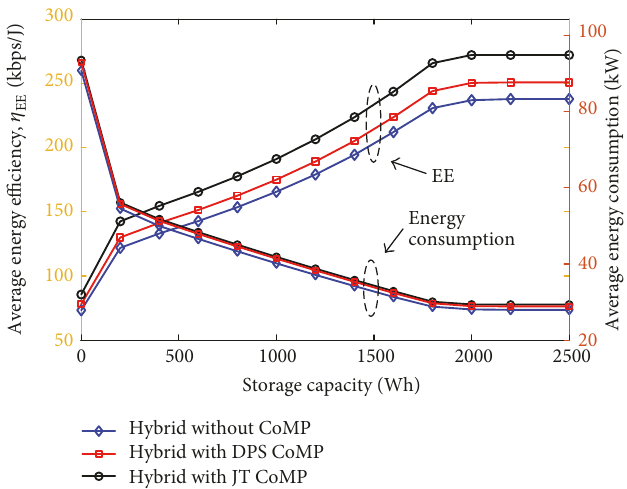
Figure 9: Comparison of EE and on-grid power consumption for the three di ff erent hybrid schemes without sharing.